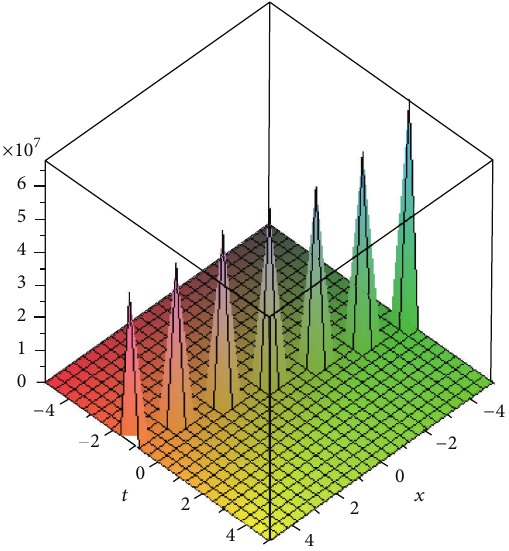
Figure 8: The plot of solution (60) with 𝑝 = 1 , 𝐴 = 6√2 , 𝑅 = 𝐵 = 3 , and 𝑘 = 0